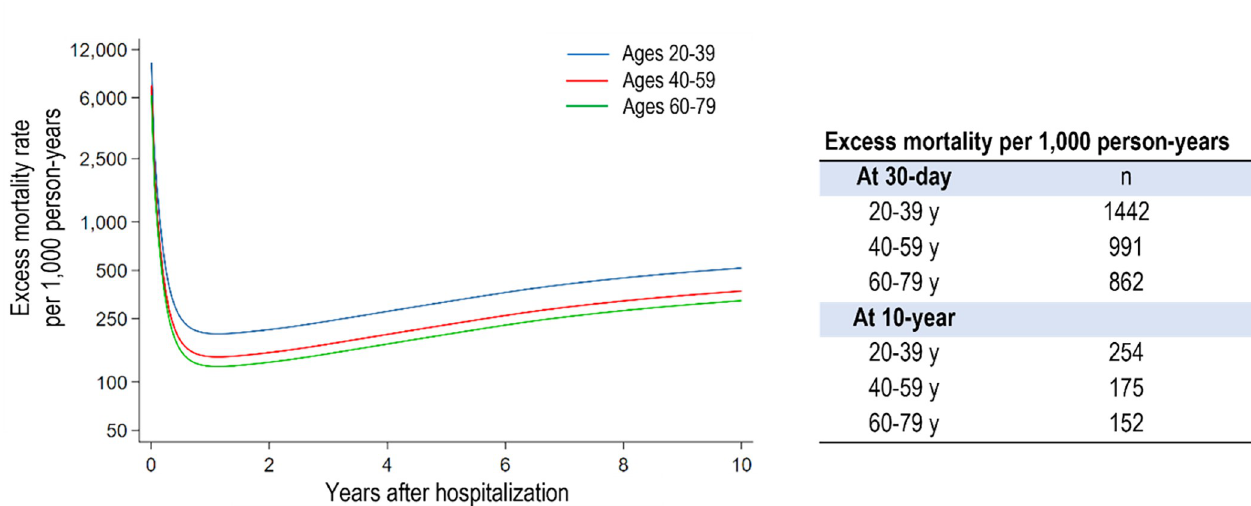
Fig 4. Excess mortality compared to the age and sex-matched general population associated with the index hospitalization in differential age groups.